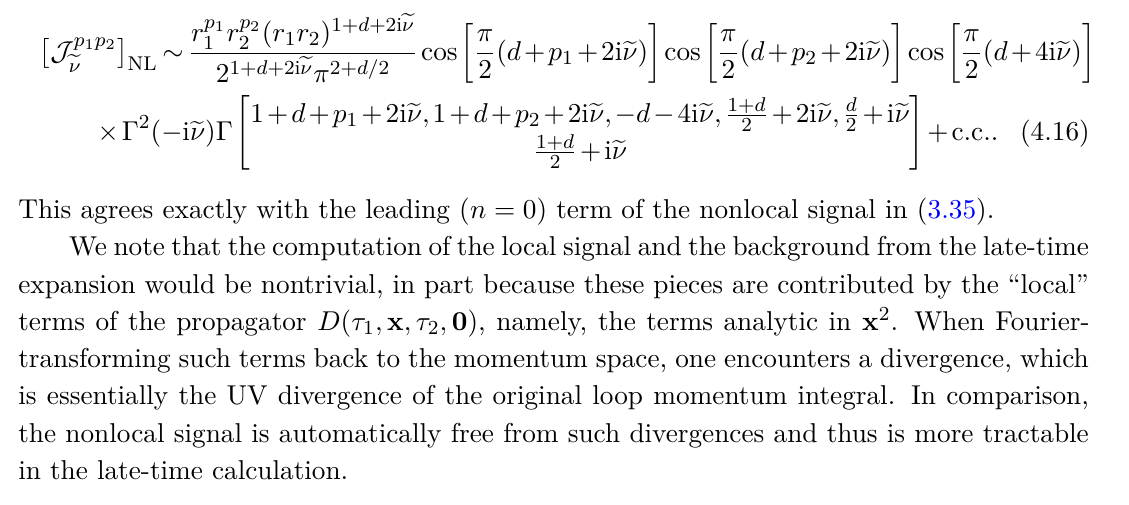
Figure 3 . The convergence of the loop seed integral. In the left panel, we show the convergence of the signals J − 2 , − 2 + J − 2 , − 2 (magenta) and the background J − 2 , − 2 NS LS two classes of curves, the three curves from lighter to darker colors show the sums of the series up to n ’th power of r , with n = 5 , 15 , 25 , respectively. In the right panel, we show the sum of the 1 /r 2 signals and the background, again, with three choices of n . The grey dotted curve shows the interpo- lated function of the whole seed integral. In this plot we fix d = 3 , p directly finished, and we